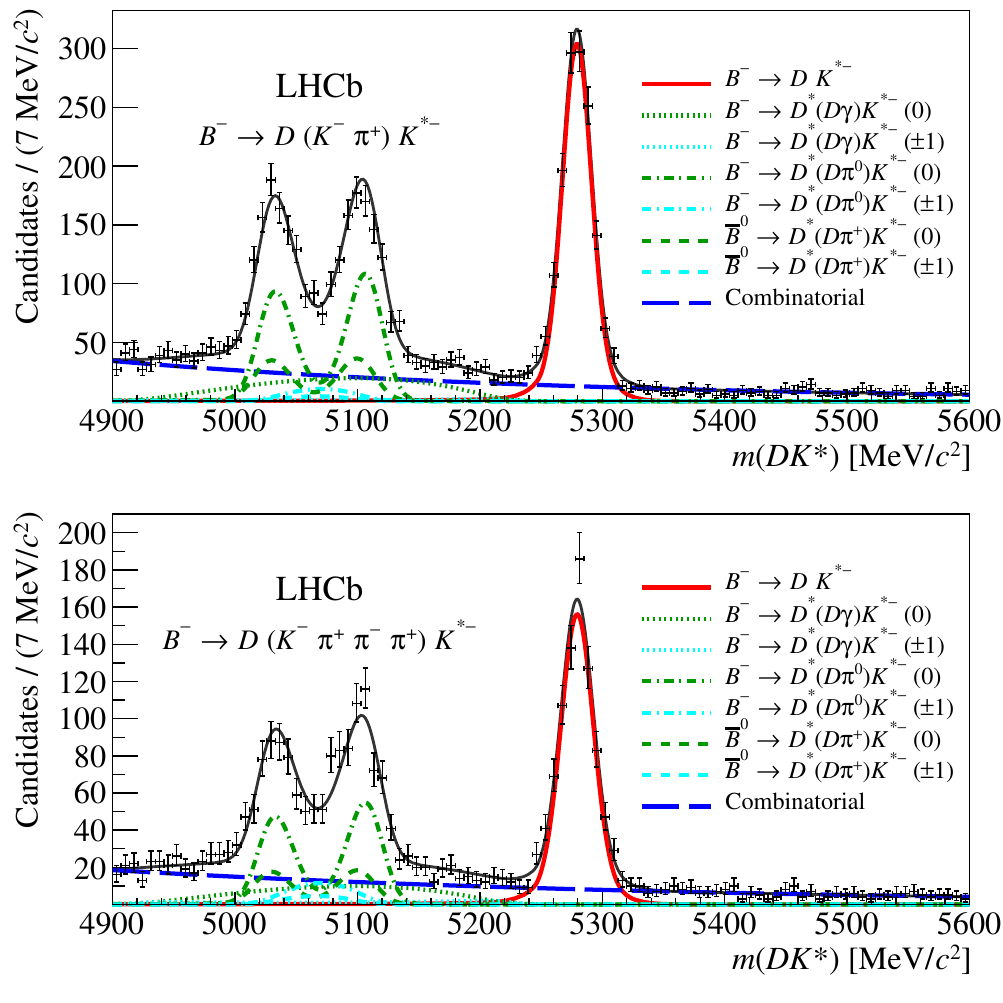
Figure 1. Invariant mass distribution with the (cid:12)t result superimposed for the favoured B (cid:0) ! D ( K (cid:0) (cid:25) + ) K (cid:3)(cid:0) decay mode (top), and B (cid:0) ! D ( K (cid:0) (cid:25) + (cid:25) (cid:0) (cid:25) + ) K (cid:3)(cid:0) decay mode (bottom), using Run 1 and Run 2 data combined. The labels 0 and (cid:6) 1 correspond to the helicity state of the D (cid:3)